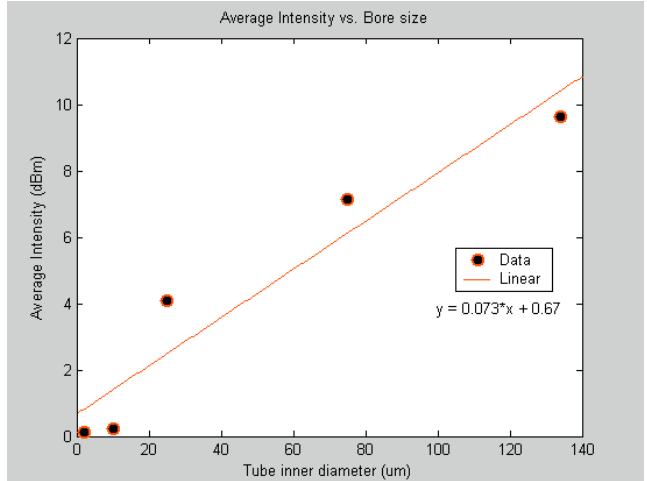
Figure 4. Average Intensity vs. Bore size (50 mm path length) at 10 Psi.